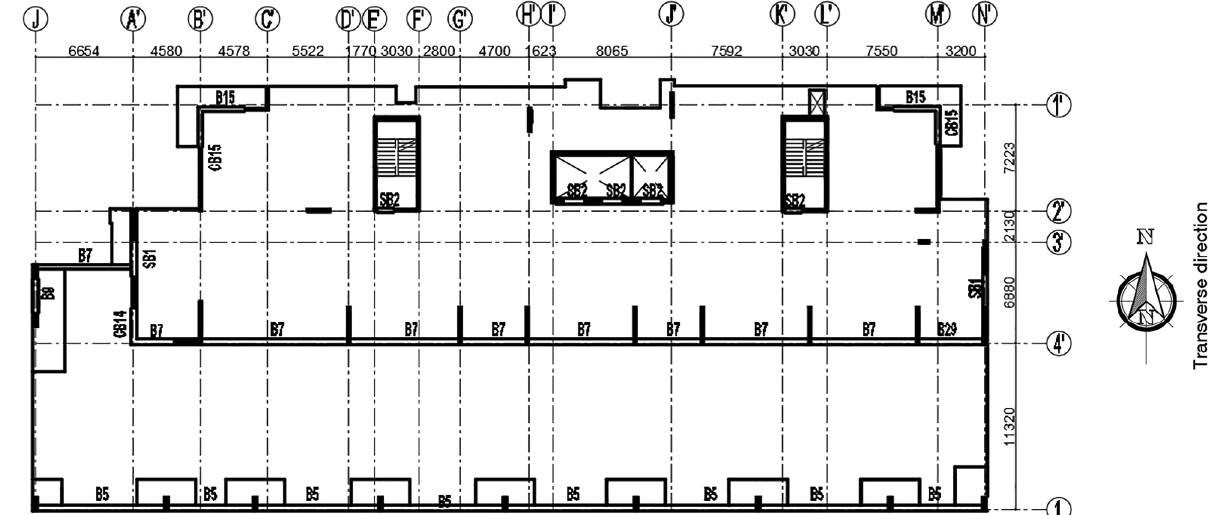
Figure 1. Plan view of the overall framing layout for the basement and ground floor